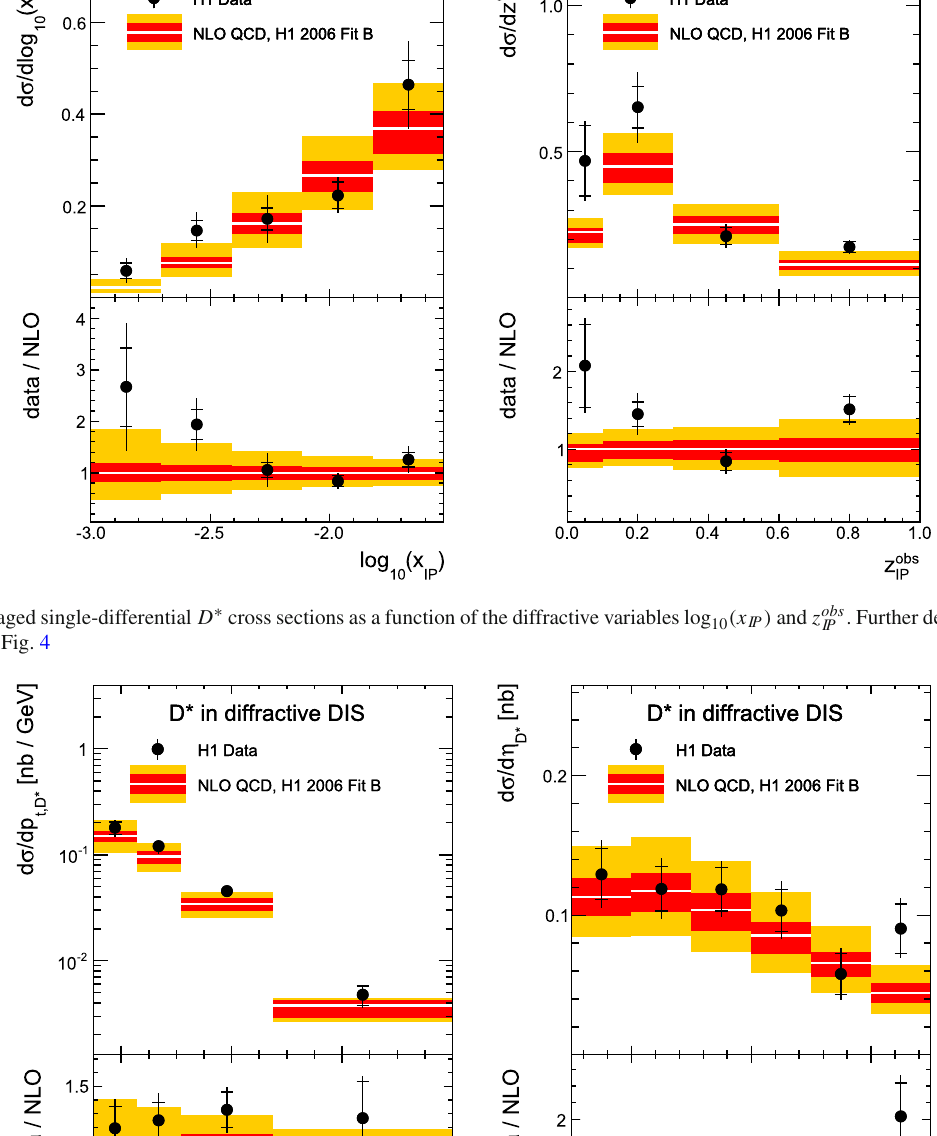
Fig. 6 Bin averaged single-differential D ∗ cross sections as a function of p t , D ∗ and η D ∗ . Further details are indicated in the caption of Fig.